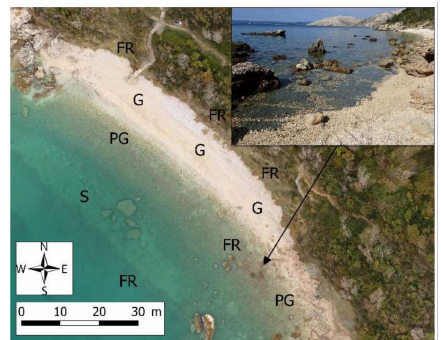
Figure 10. The beach and cliff formed in flysch rock (near cross-section D , Figure 4): FR—Flysch rock, G—Fine to coarse gravel, PG—Pebbles and coarse gravel,